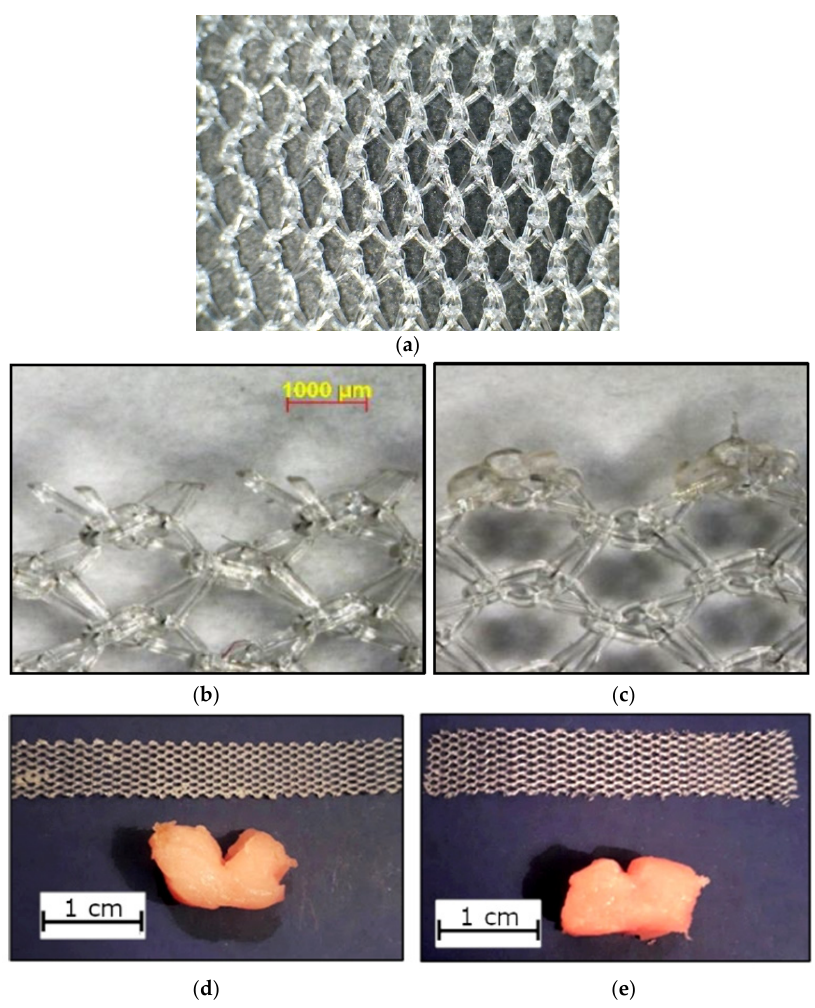
Figure 7. ( a ) Sutulene mesh material; ( b ) mesh edge cut with a scalpel; ( c ) mesh edge cut with a laser; ( d ) a specimen made with a laser-cut edge, showing the cut made in the tissue sample after testing; ( e ) as ( d ), but with a scalpel-cut sample tested under the same conditions. We used the depth of this cut to characterize the erosion